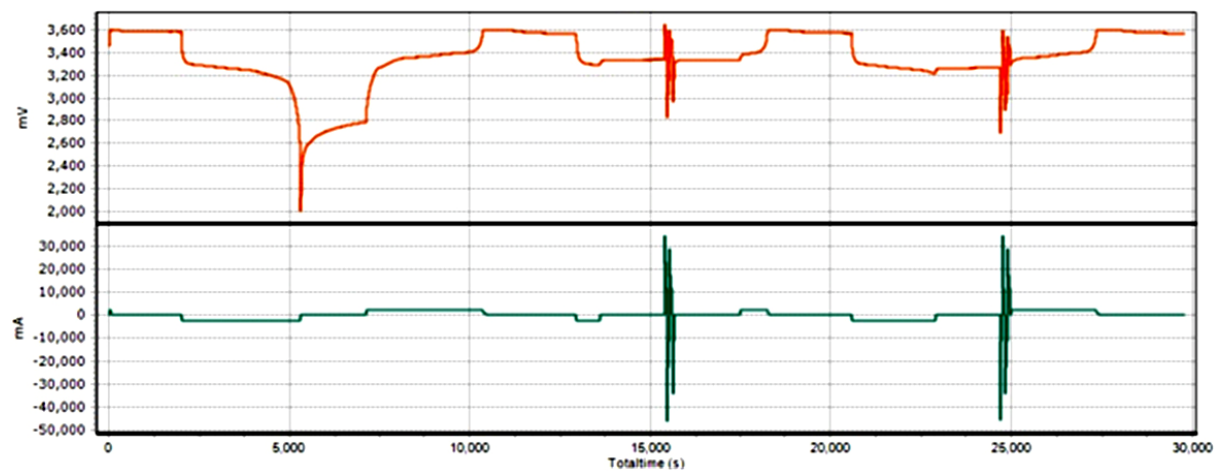
Figure 17. An example of the initial charge and discharge micro